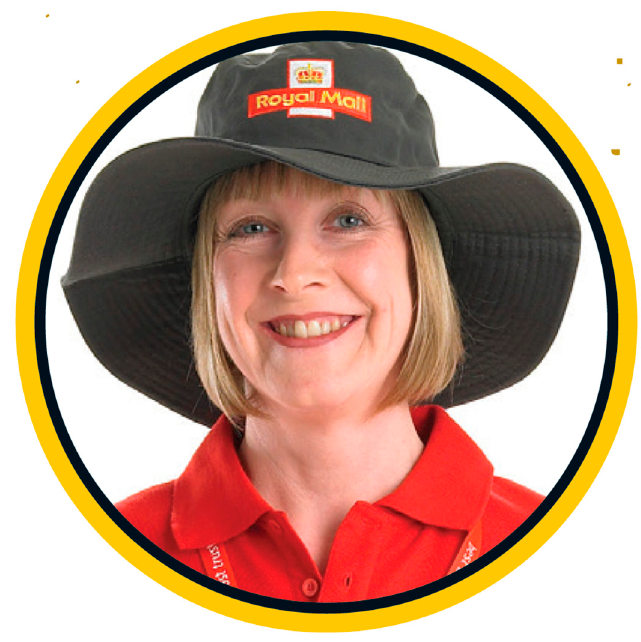
Figure 1. Royal Mail Group wide-brimmed hat.